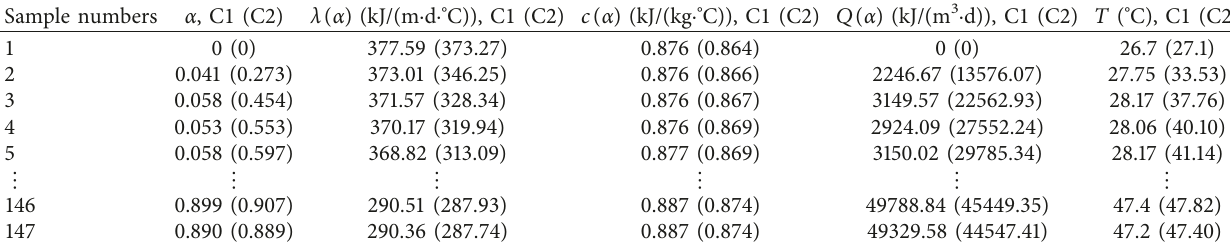
Table 6: Sample data of back analysis with BP network.